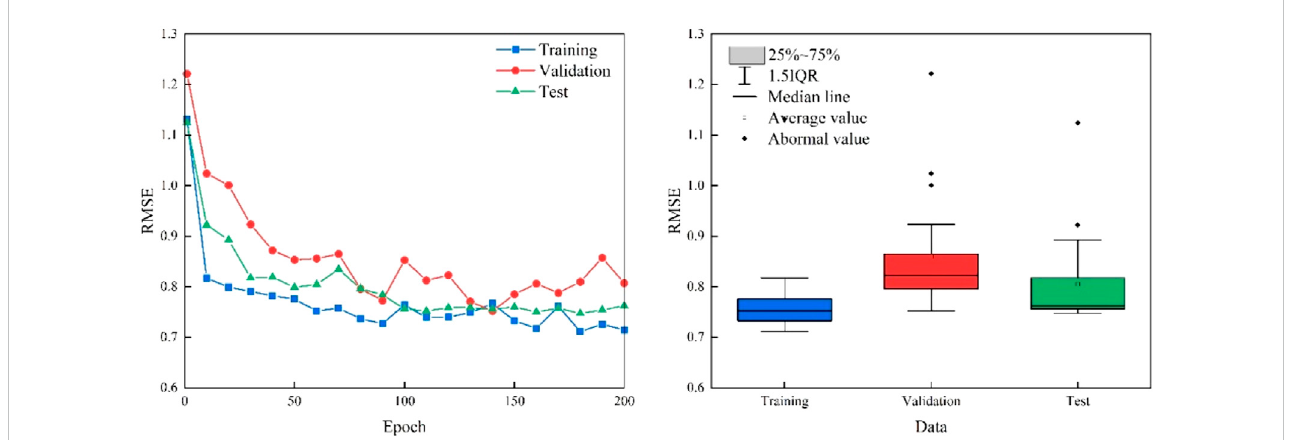
FIGURE 6 The root-mean-square error of the learning system at the training, validation, and testing stages with 200 epochs.